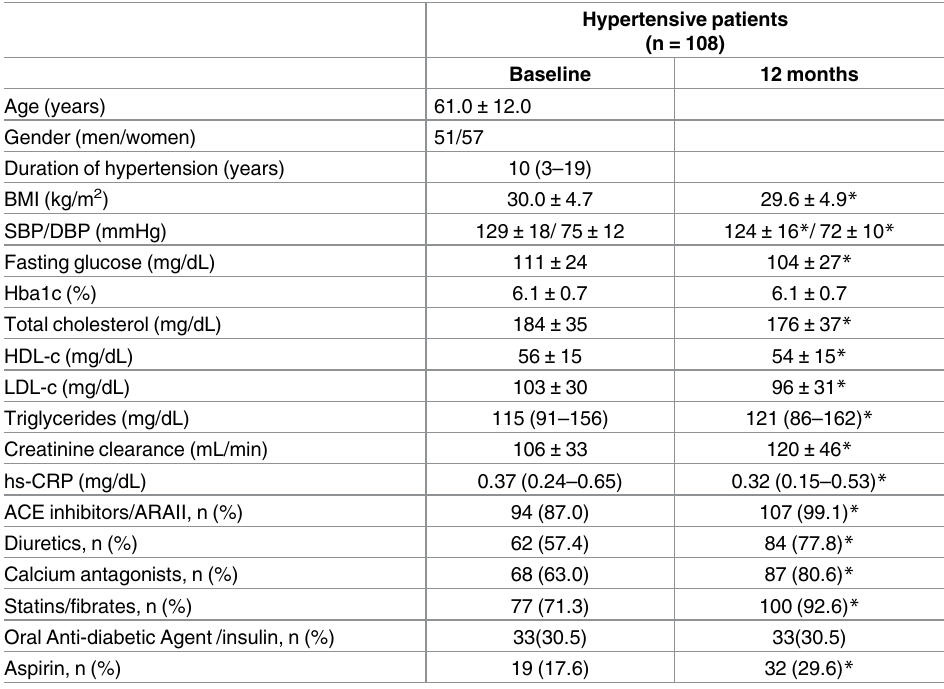
Table 1. Clinical-biochemical parameters and drug treatment of hypertensive patients at start (base- line) and after treatment intensification during 12